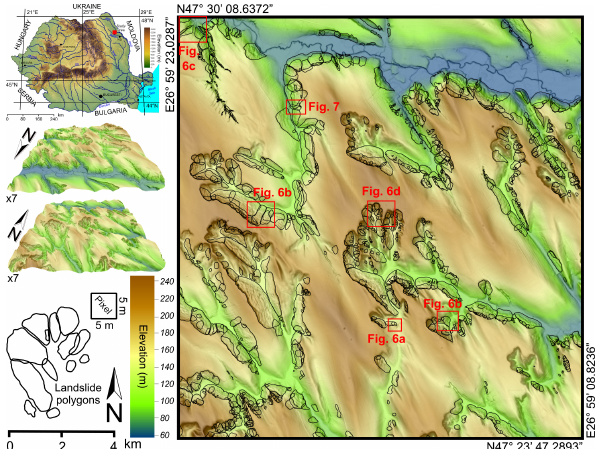
Figure 3. The study area and the landslide inventory overlaid on shaded lidar DEM. The upper-left panel is an inset showing the po- sition of the study area in Romania; below the inset, a set of 3-D views of the study area landforms from north and south is displayed. The red boxes from the map on the right indicate the insets from Figs. 6 and 7.